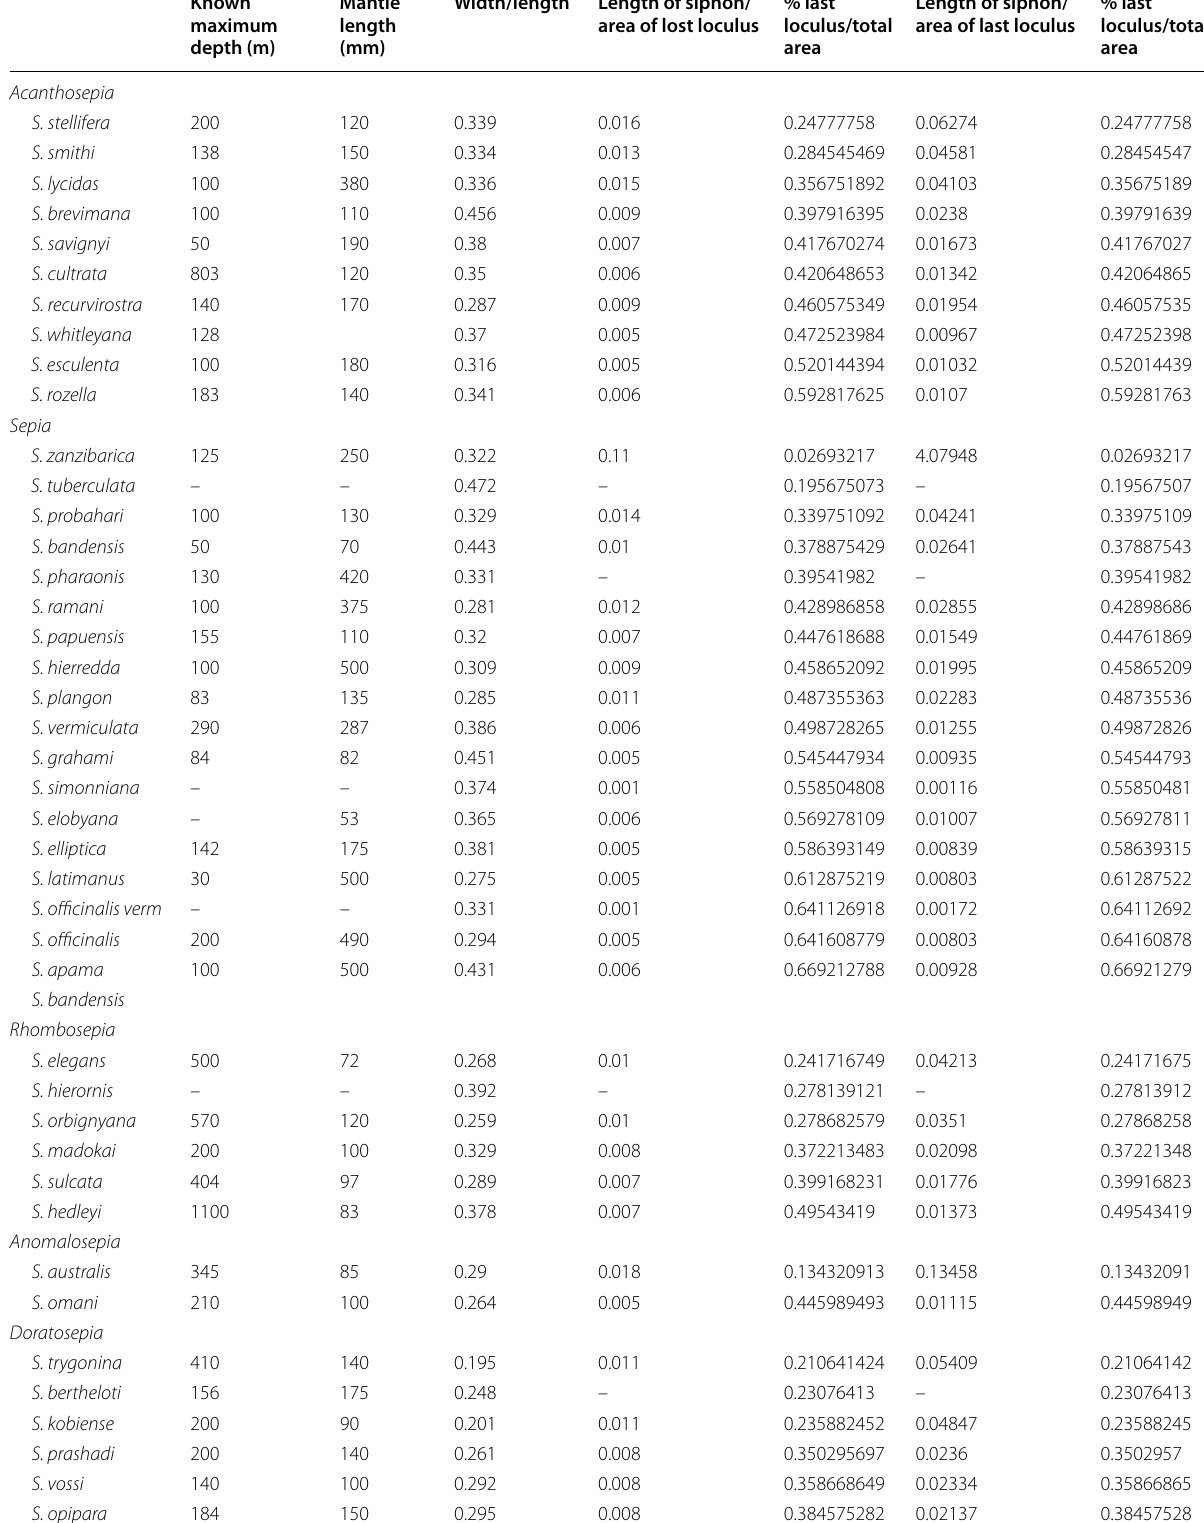
Table 1 Measurements of Sepiid cuttlebones arranged in different subgenera, showing ratios of different morphological features Known